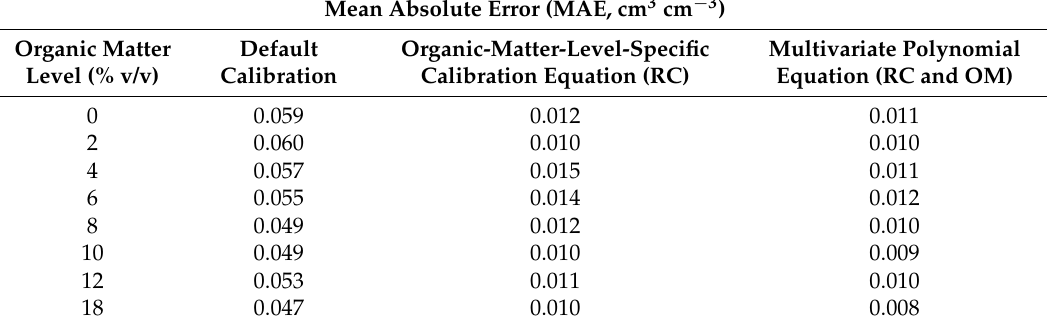
Table 3 . Comparisons between accuracy of the default calibration on one hand and the organic-matter-level–specific and multivariate polynomial calibration equations on the other hand.